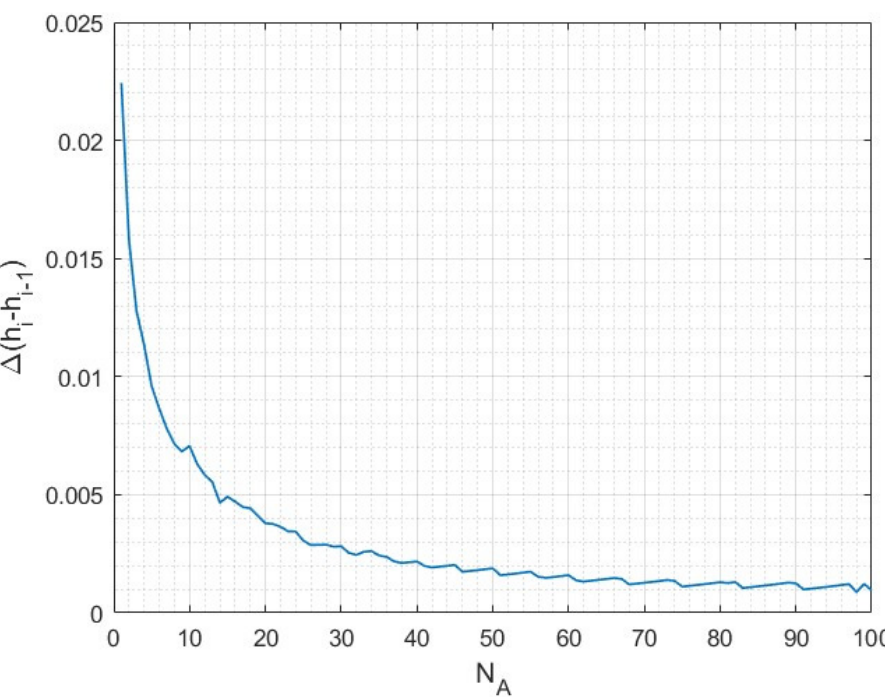
Figure 16. Deviation in inflow depth Δ ( h i − h i − 1 ) vs. the number of arrays N A .